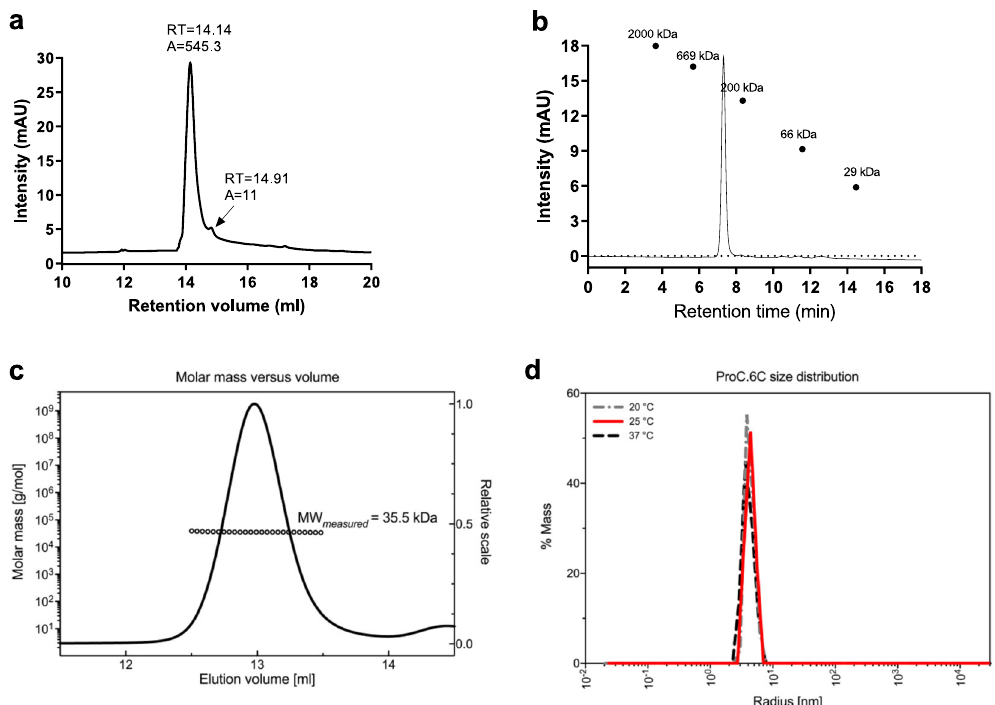
Fig. 4 Characterization of ProC6C. a Reversed-phase (RP) HPLC. Reversed-phase HPLC – UV chromatogram recorded following analysis of puri fi ed ProC6C. The peak at 14.14 ml corresponds to monomeric ProC6C antigen. b Size-exclusion chromatography (SEC) HPLC analysis. SEC- protein concentration was used to compute the molar masses. The solid line plotted on the right axis corresponds to the change in refractive index from the SEC column. The right axis is normalized to the greatest magnitude across the chromatogram data, i.e., to the monomer